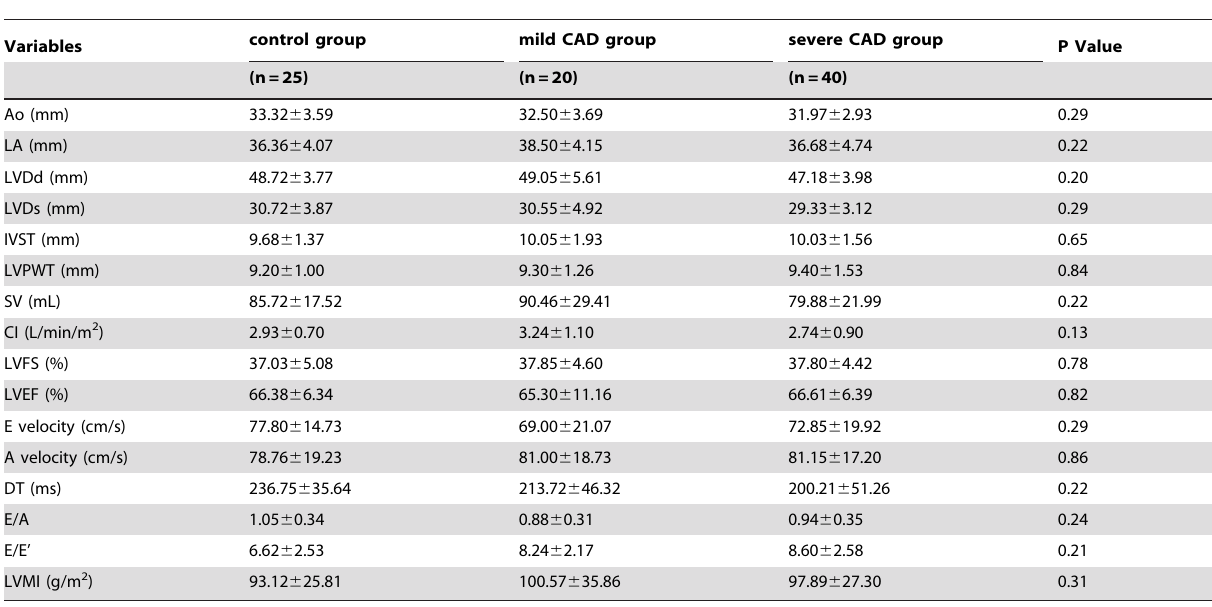
Table 2. Echocardiographic parameters in patients and